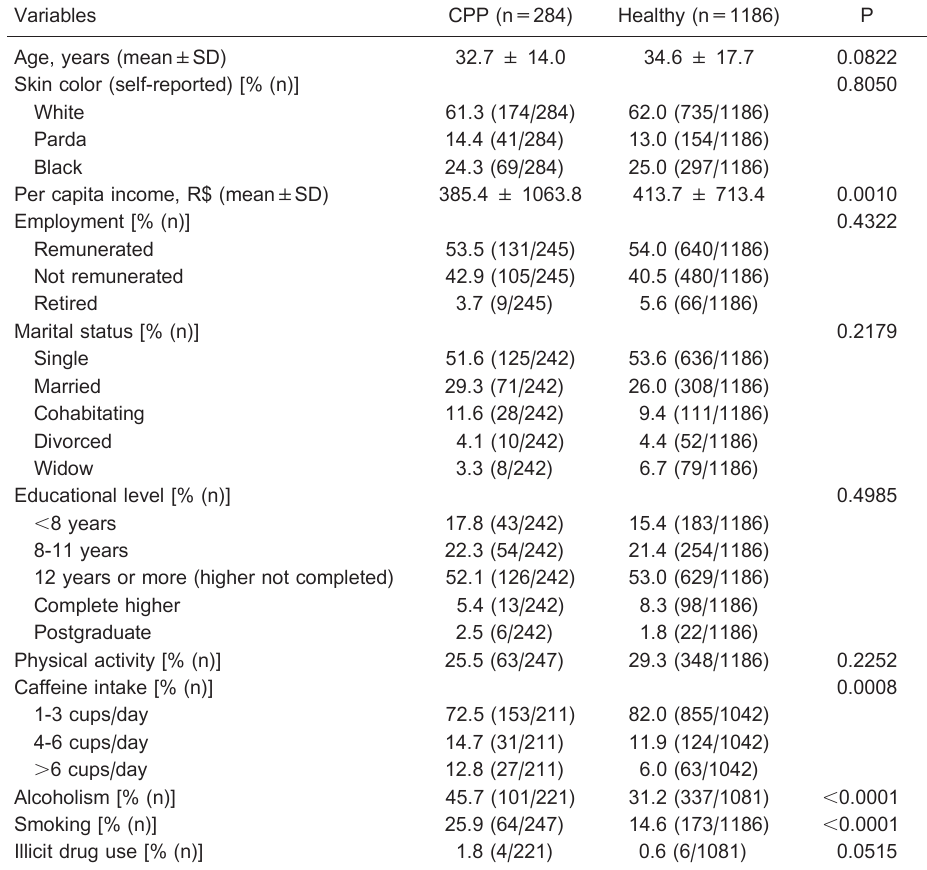
Table 1. Characteristics of social, economic and cultural variables of women with chronic pelvic pain (CPP) and healthy